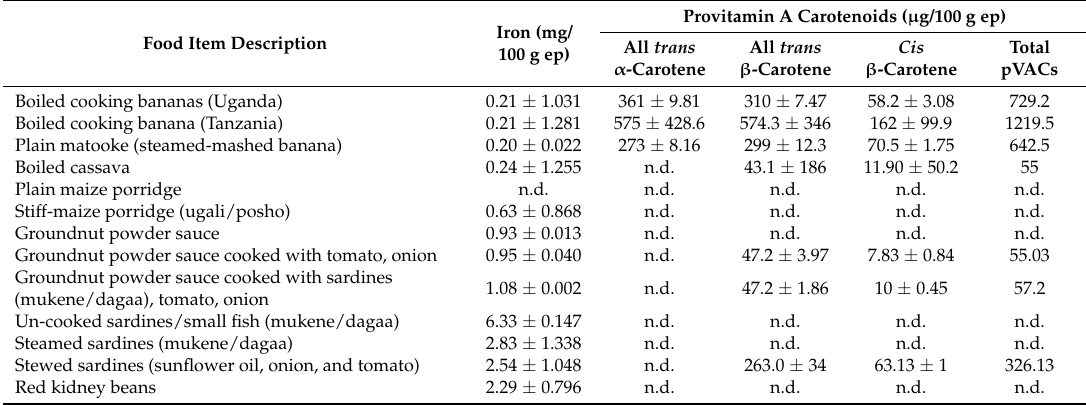
Table 2. Iron and provitamin A carotenoid contents (pVACs) of both raw and cooked food ingredients used in preparing the common